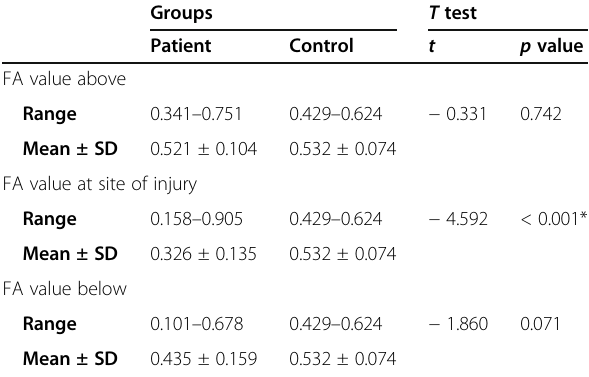
Table 3 Comparison of FA parameter between patients and control group Groups T